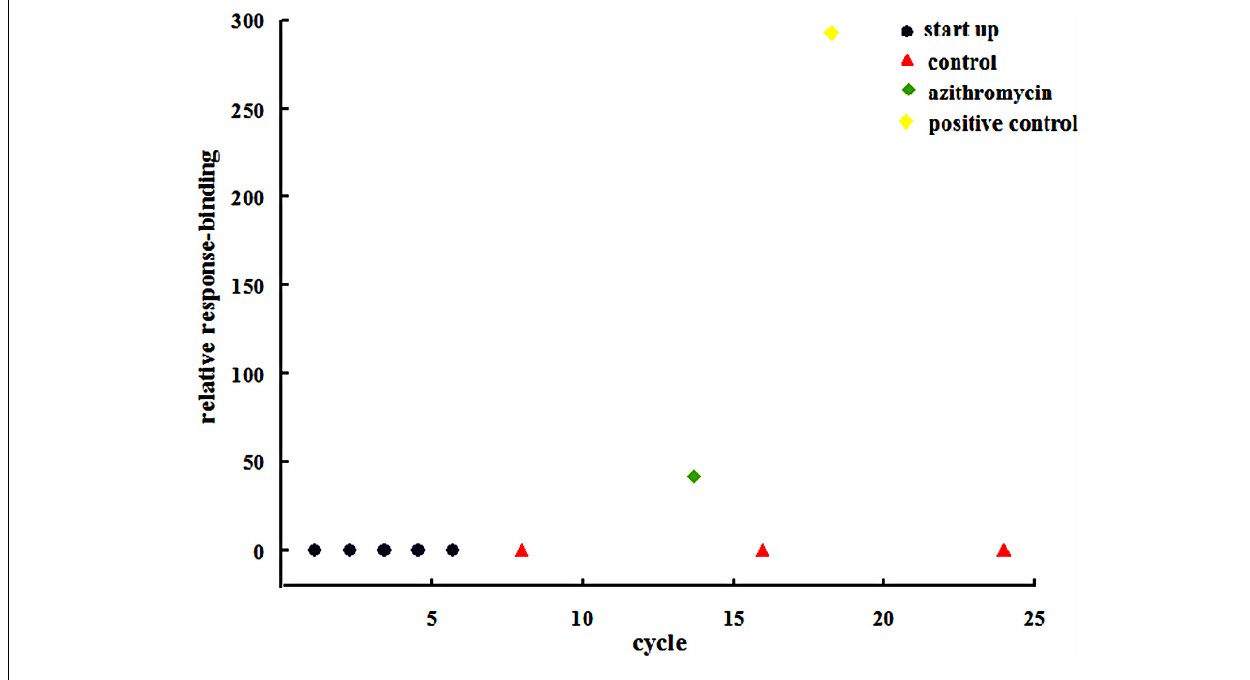
Figure 4 | Surface plasmon resonance analysis of the bond between azithromycin and IGPD.